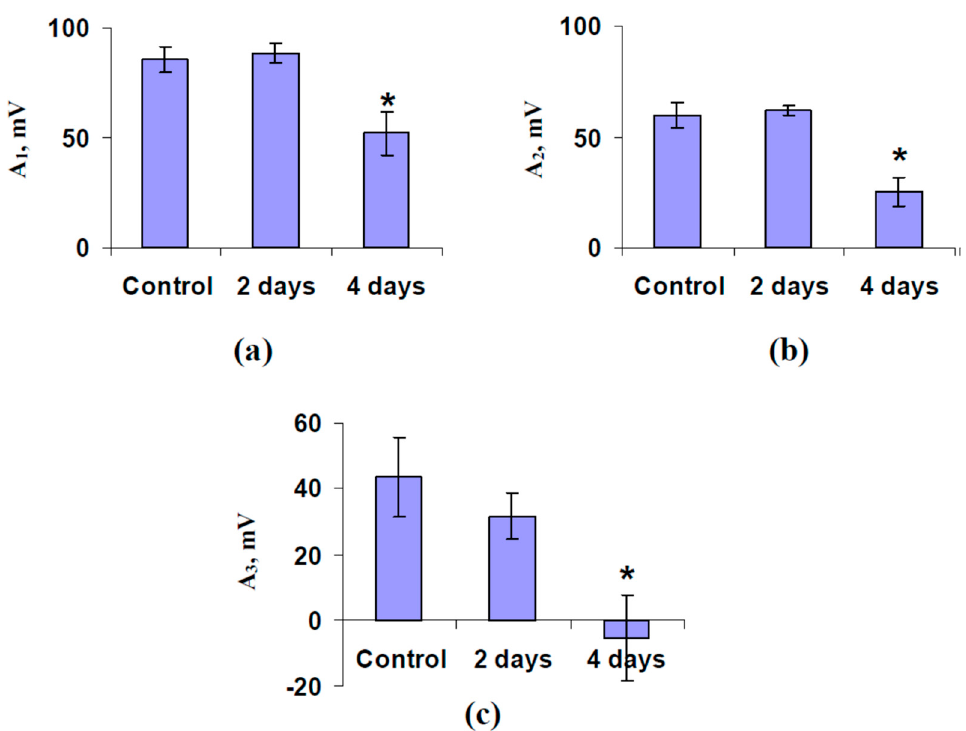
Figure 3. Influence of soil water shortage on the amplitudes of the burning-induced electrical signals in the stem near to the first mature leaf (A 1 ) ( a ), the stem near to the second mature leaf (A 2 ) ( b ), and leaflet of the second mature leaf (A 3 ) ( c ) in pea seedlings ( n = 6). The water shortage was initiated by the termination of irrigation of the plants. It was assumed that negative amplitudes corresponded to the hyperpolarization signal. *, the amplitude significantly differed from the one in the control pea seedlings ( p < 0.05, Student’s t -test).